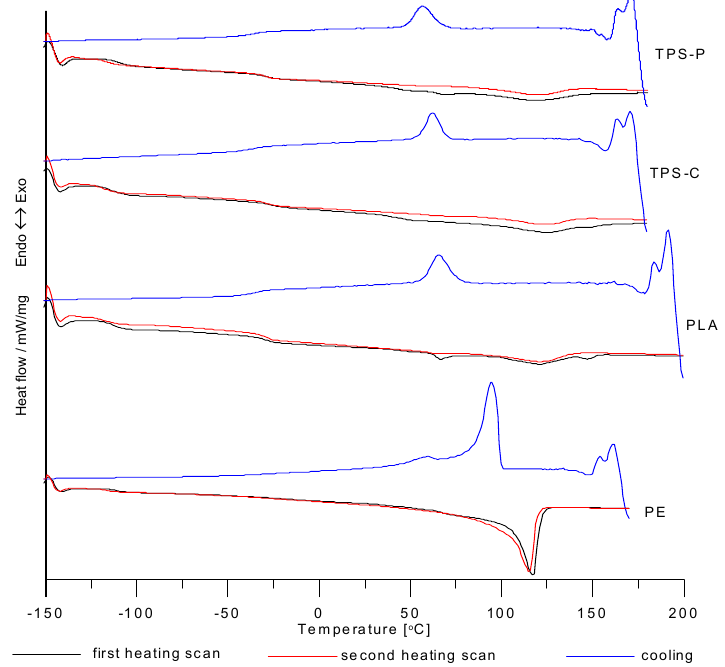
Table 2. DSC measurement results for granulates.